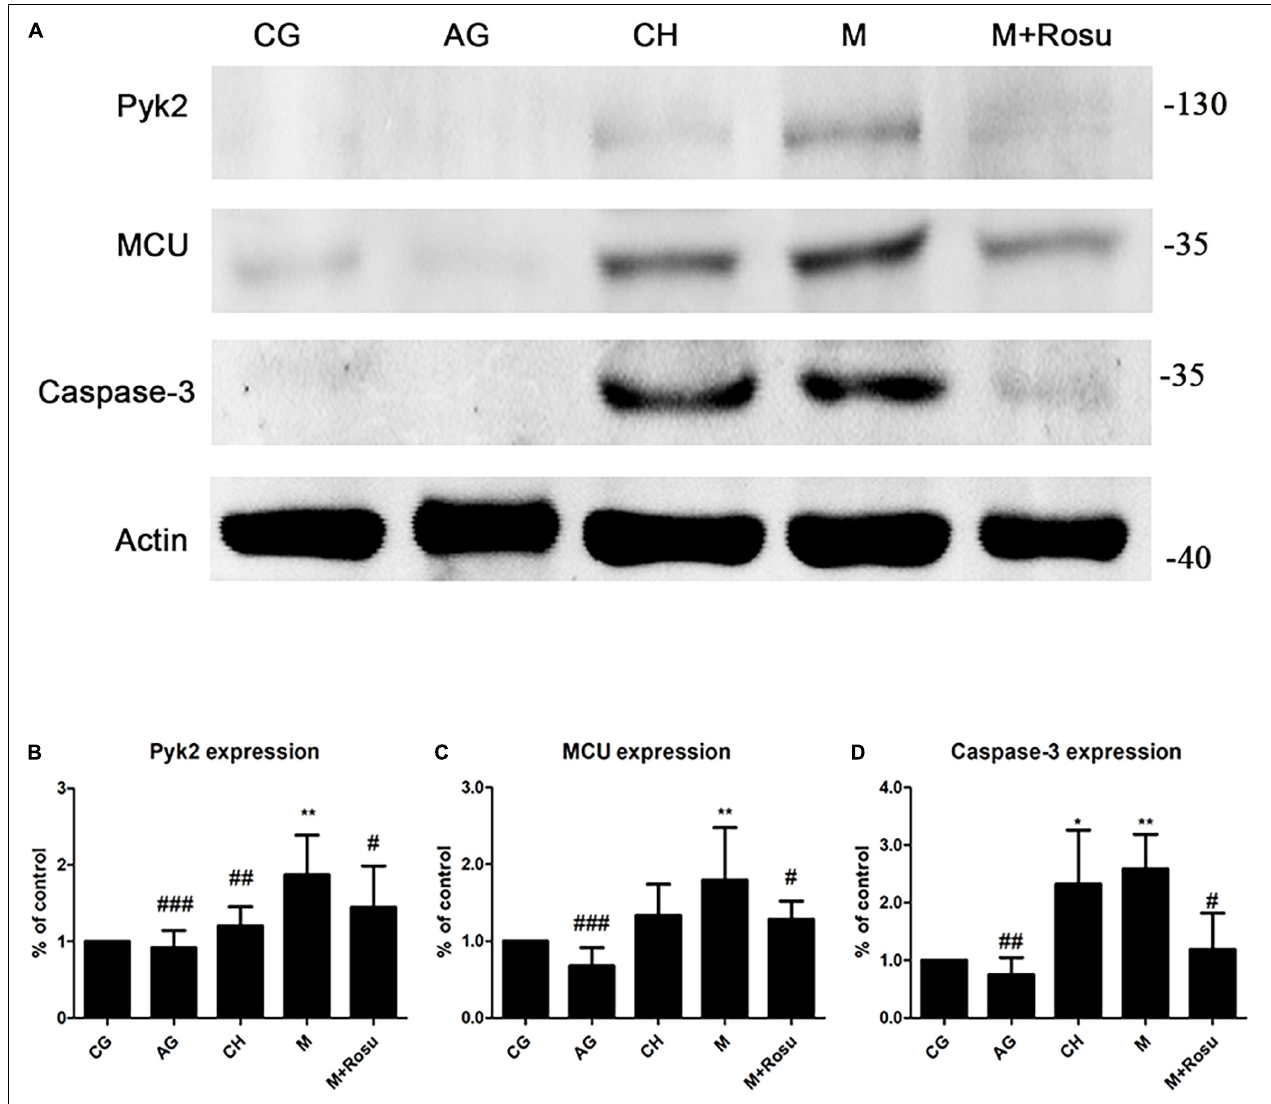
FIGURE 3 | The expression of Pyk2/mitochondrial calcium uniporter (MCU) after atherosclerosis (AS) and rosuvastatin intervention in a mouse model of AS by western blot. (A) The protein expression of Pyk2, MCU, and caspase-3. (B–D) Statistical graph of Pyk2 (B) , MCU (C) , and caspase-3 (D) . Data are shown as mean ± SD of at least three independent experiments. * P < 0.05, ** P < 0.01 versus vehicle control (CG); # P < 0.05, ## P < 0.01, ### P < 0.001 versus vehicle model (M), one-way ANOVA and unpaired Student’s t -test ( a = 0.05 as inspection level, M versus M+Rosu). CG, C57BL/6J+general diet; AG, ApoE – / – +general